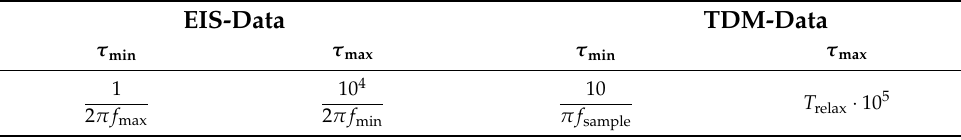
Table 1. Limits of predefined relaxation